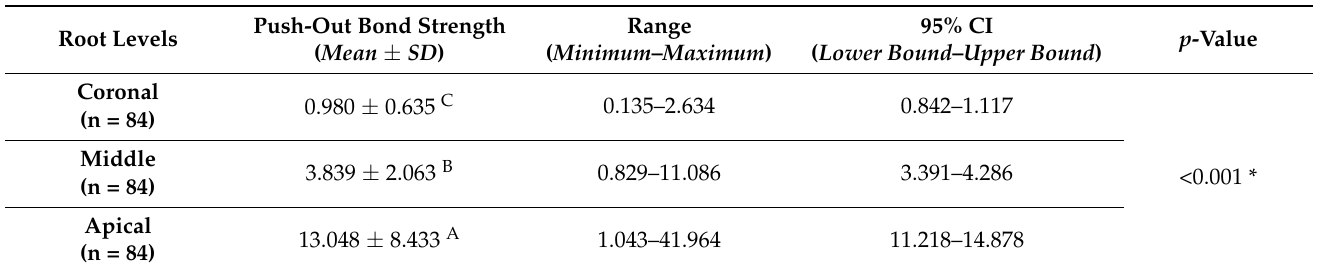
Table 2. Comparison of push-out bond strength means (in MPa) between root levels regardless of the sub-groups (n = 252).